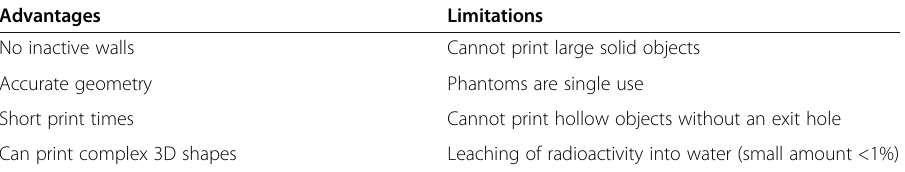
Table 4 Advantages and limitations of radioactive 3D printing technique